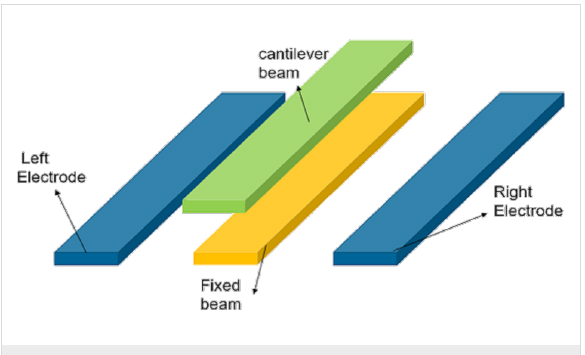
Figure 11: The structure of the sensor-switch system. Figure 11 was redrawn from